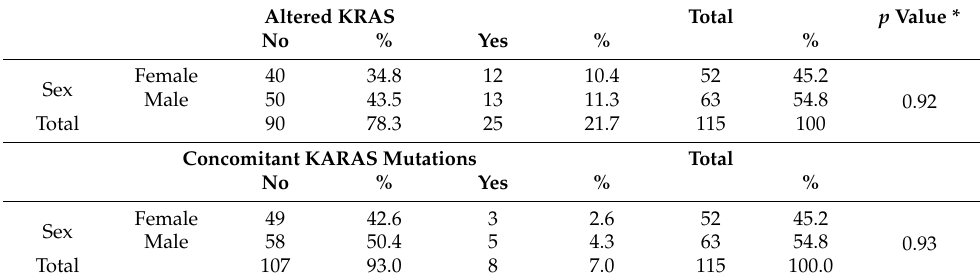
Table 2. Patient sex versus KRAS